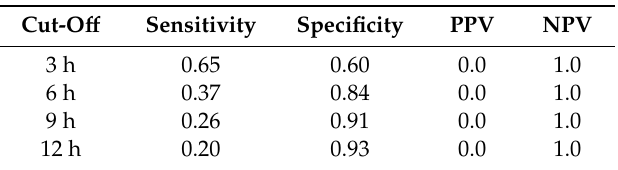
Table 2. Sensitivity and specificity of each time cut-o ff of stay in the emergency department predicting in-hospital cardiac arrest (IHCA). Cut-O ff Sensitivity Specificity PPV NPV 3 h